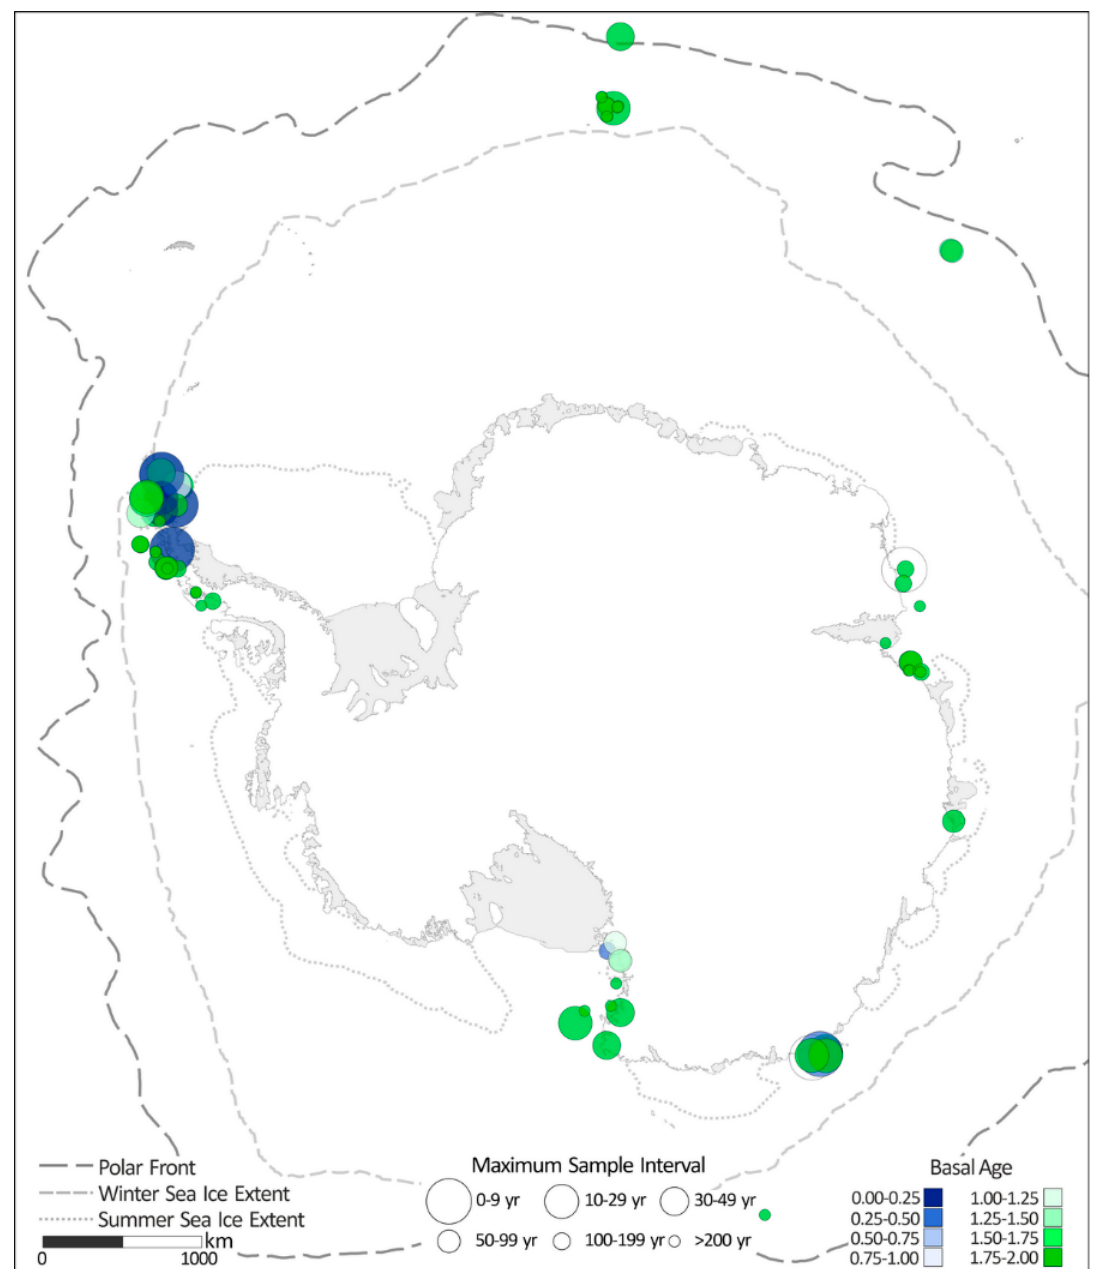
Figure 11. Map of sites that include F. curta in at least one proxy record. The symbol size reflects the resolution of the record and the color of the symbol indicates the basal age of the record between 0 and 2 ka BP. The hollow circle symbols are used for discrete and/or discontinuous records from laminated sediments to illustrate the resolution only.